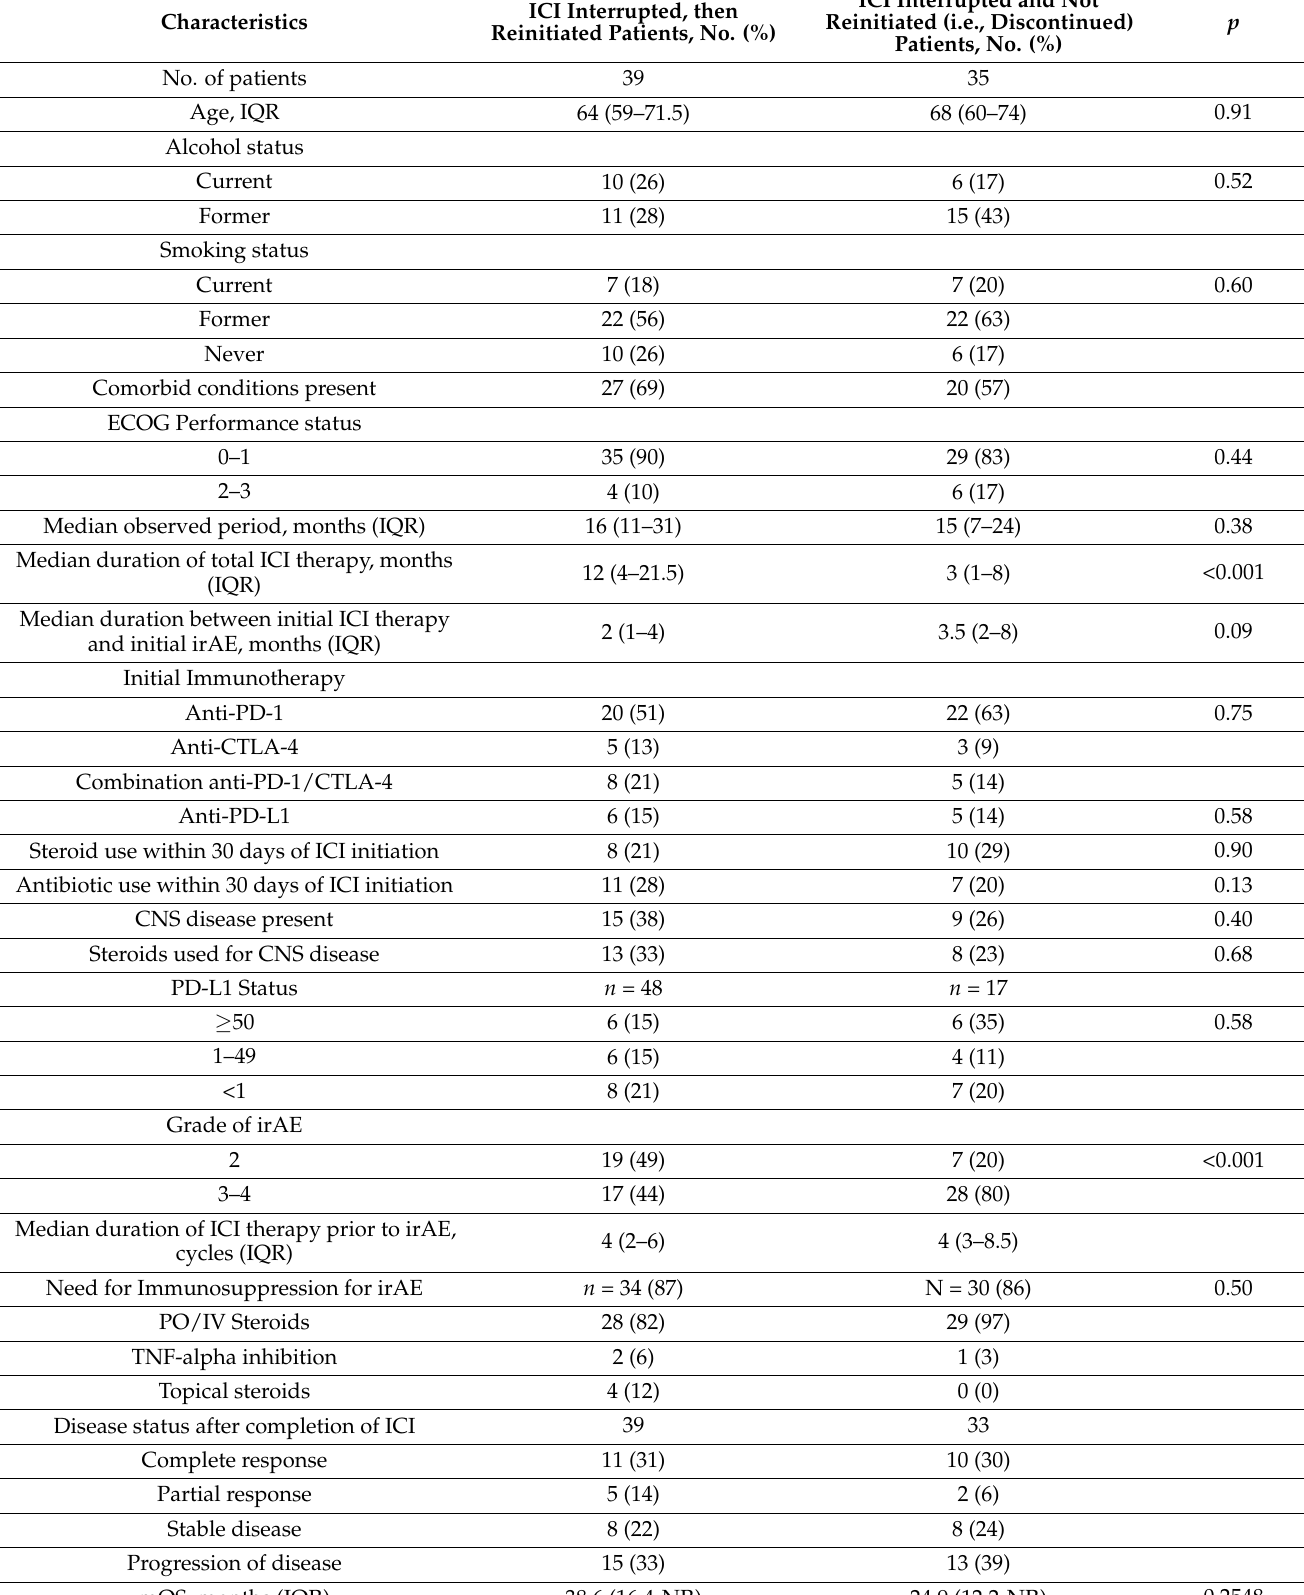
Table 4. Characteristics of Patients with IrAE and Stratified by ICI Interrupted Status.